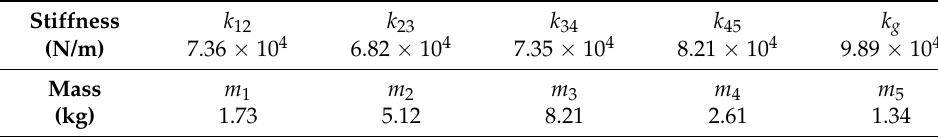
Figure 8. A 5-DOF undamped spring-mass vibration system. Table 1. System parameters.